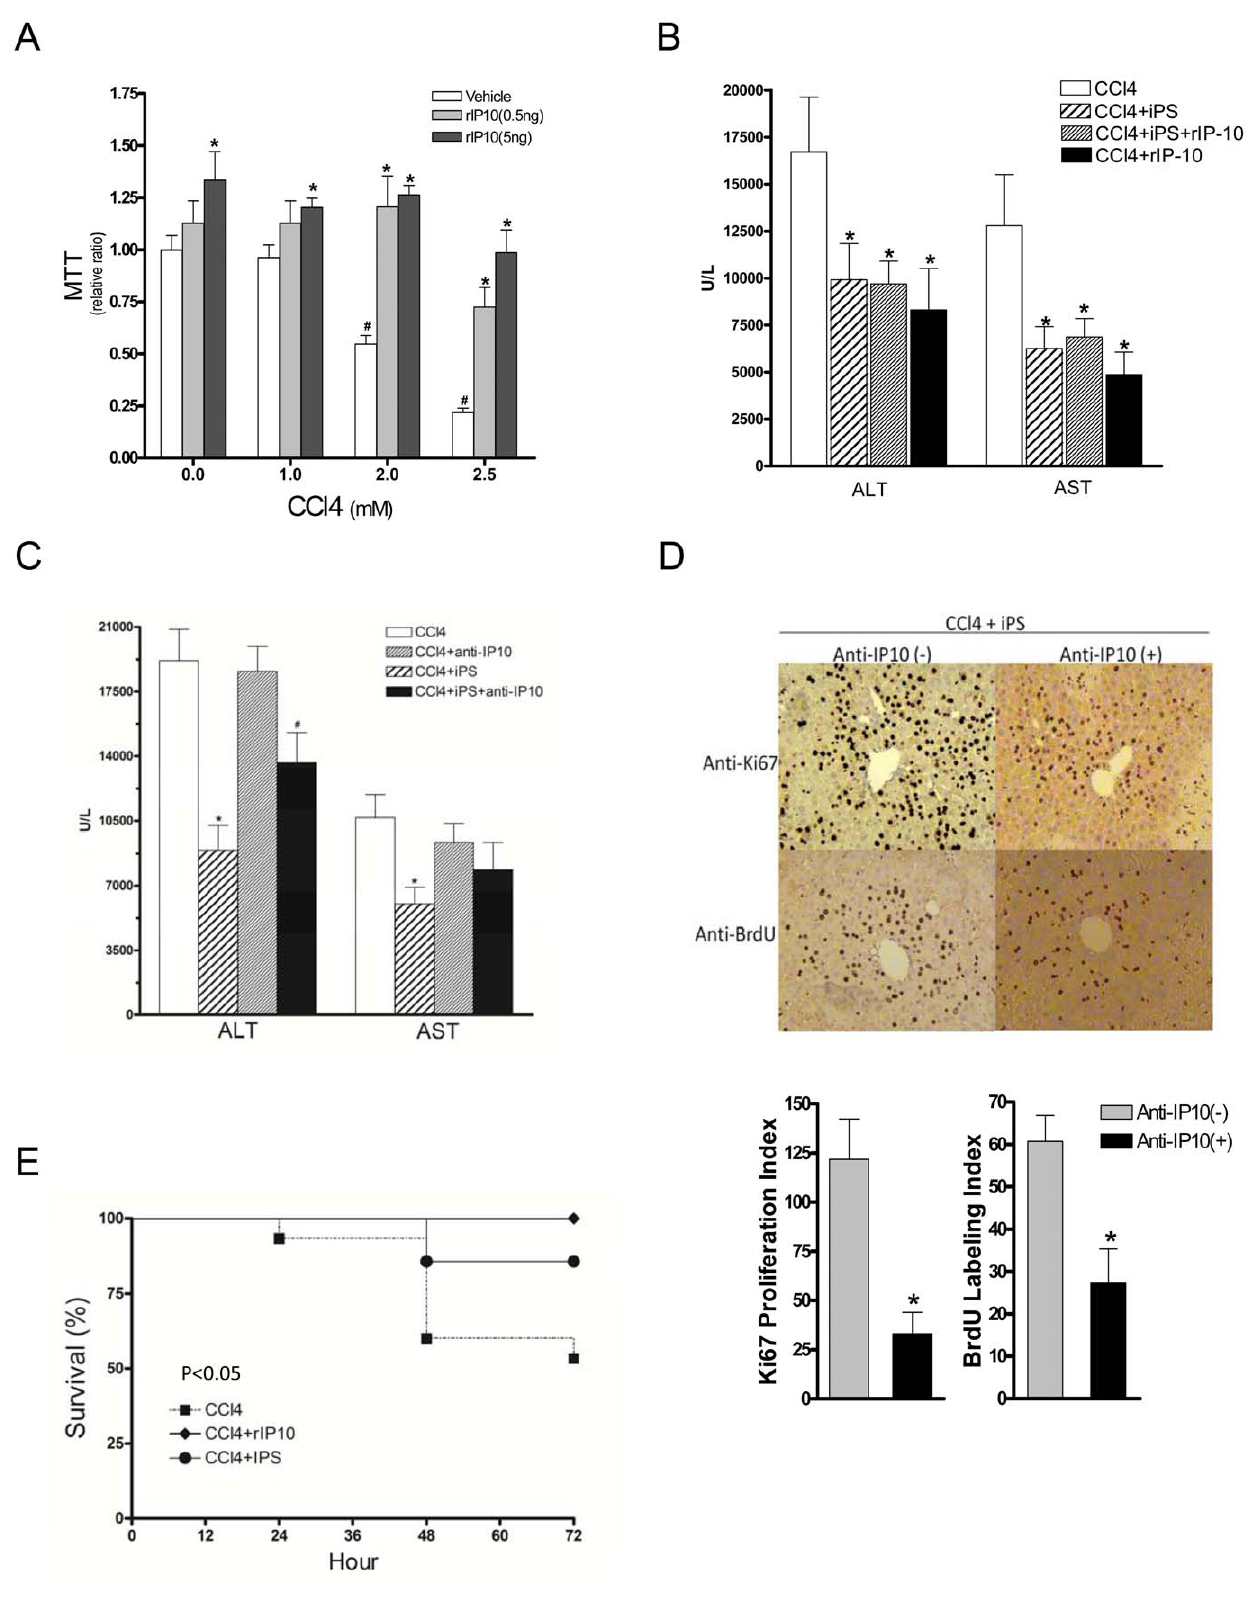
Figure 5. IP-10 is an important factor that mediated the beneficial effects of iPS. ( A ) Recombinant IP-10 (rIP-10) increased the viability of injured hepatocytes 24 h after CCl 4 injury at concentration of 1.0 to 2.5 mM. ( B ) In injured mice, rIP-10 reduced the degree of liver damage and the effects of rIP-10 were compatible to iPS alone. Combined treatment of rIP-10 and iPS had no additional damage-reducing effects. ( C ) Anti-IP-10 was